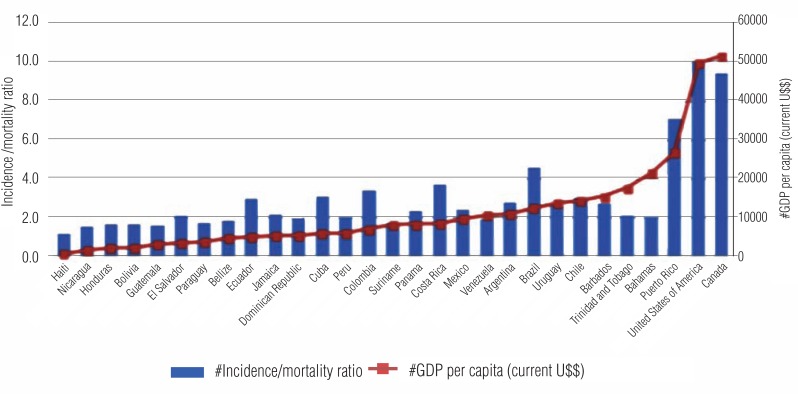
Incidence/mortality ratio of prostate cancer, compared to gnp per capita per country, 2012.